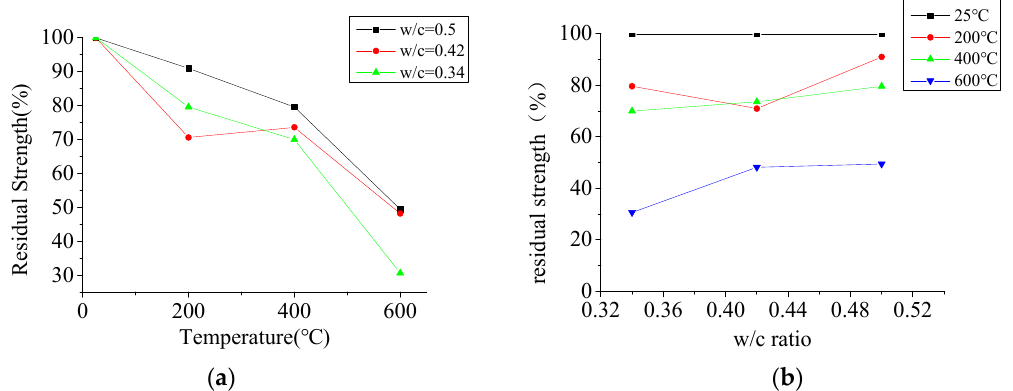
Figure 10. The residual compressive strength of specimens; (a) the effect of temperature on the compressive strength, (b) the effect of w/c ratio on the compressive strength.